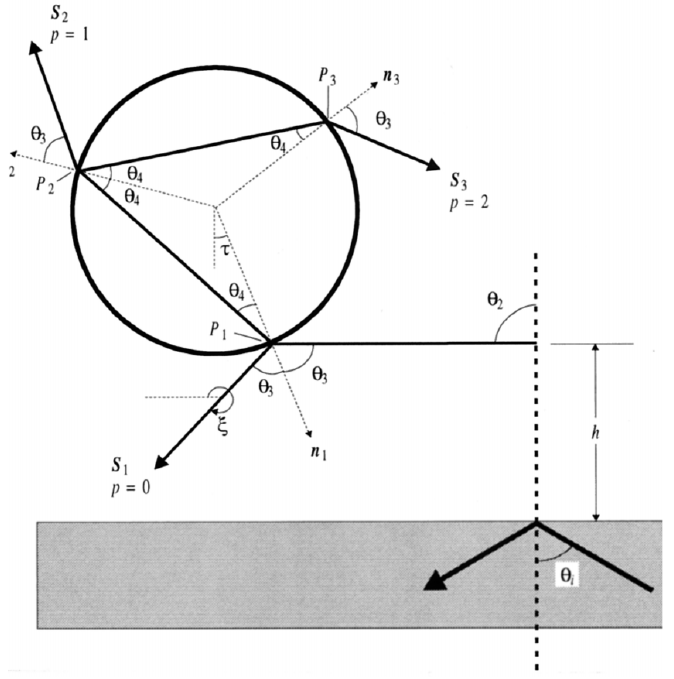
Figure 4. Schematic definition of the variables used in tracing the path of a ray through the dielectric sphere. Reprinted with permission from [56] © The Optical